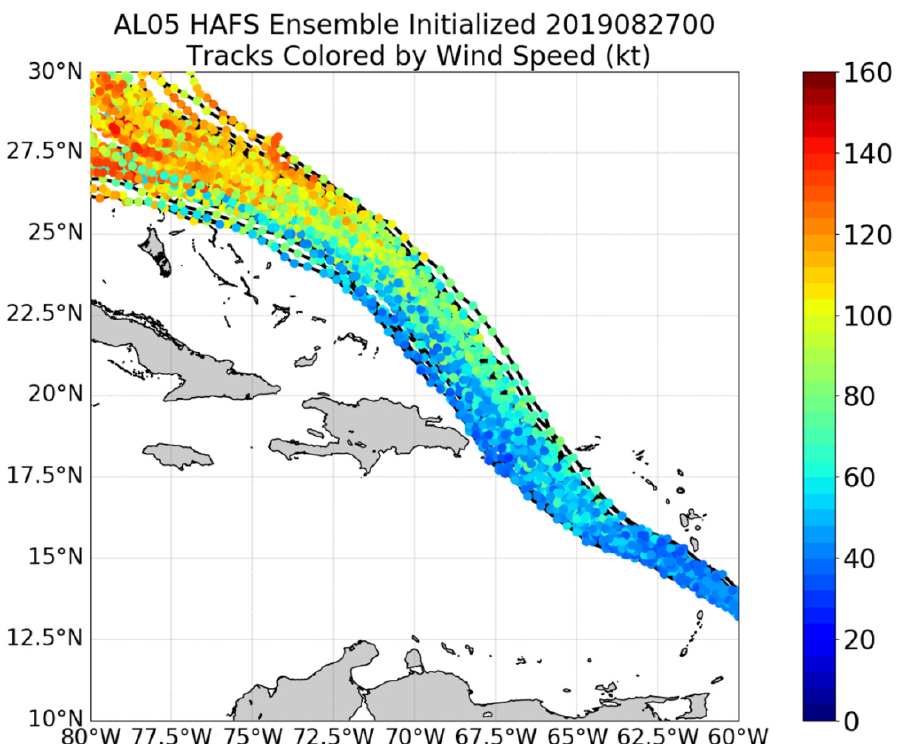
Figure 4. Storm tracks from all 80 ensemble members, zoomed in on the northeast Caribbean region. The tracks are shaded by maximum wind speed in kt (1 kt = 0.51 m s − 1 ).